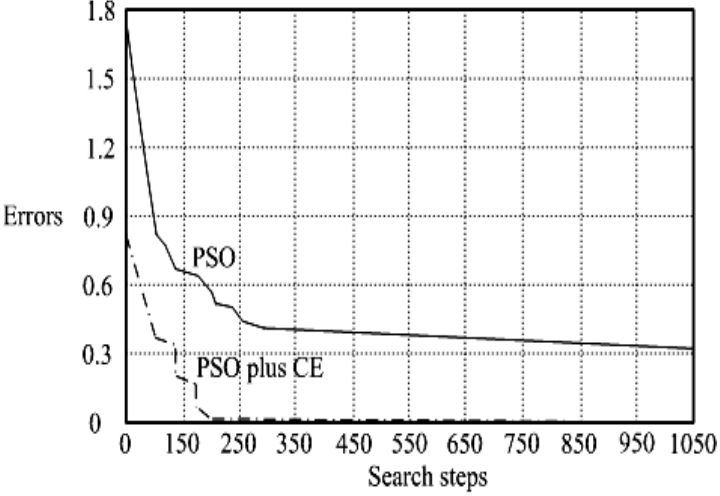
Figure 13. Simulated comparison of PSO-CE and traditional PSO in searching steps under illumination.